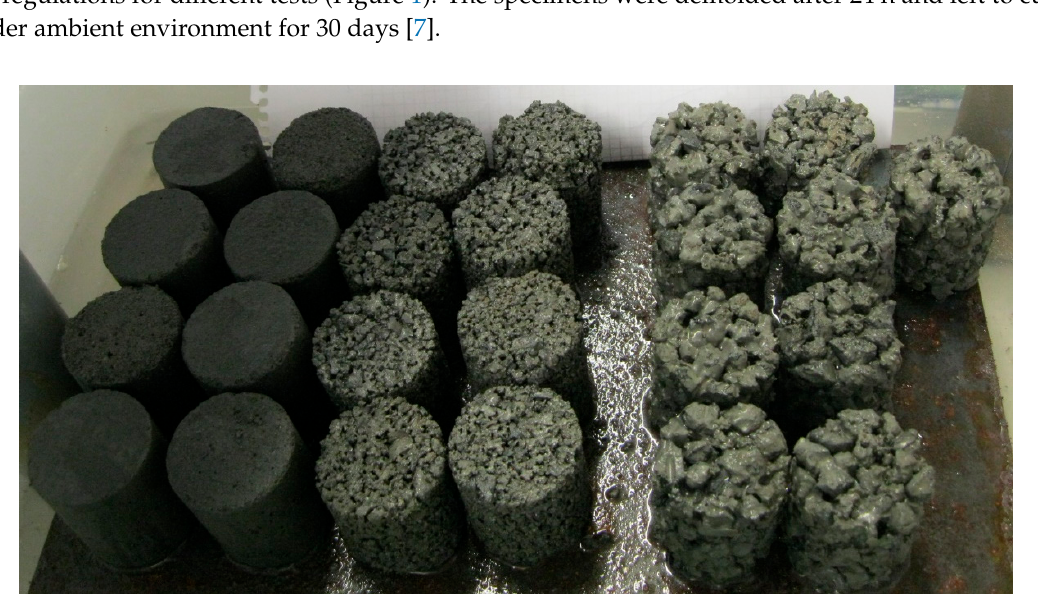
Table 1. Composition (wt%) of the specimens made from three fractions of mixed slag (MS) and